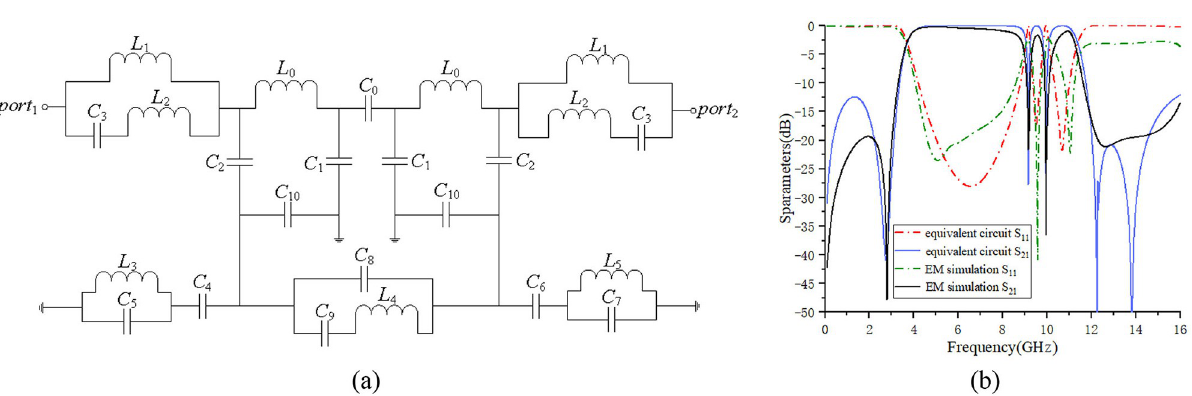
ffiffiffiffiffiffiffiffiffiffiffiffiffiffiffiffiffiffiffiffiffiffiffiffi p ð C þ C L 3 4